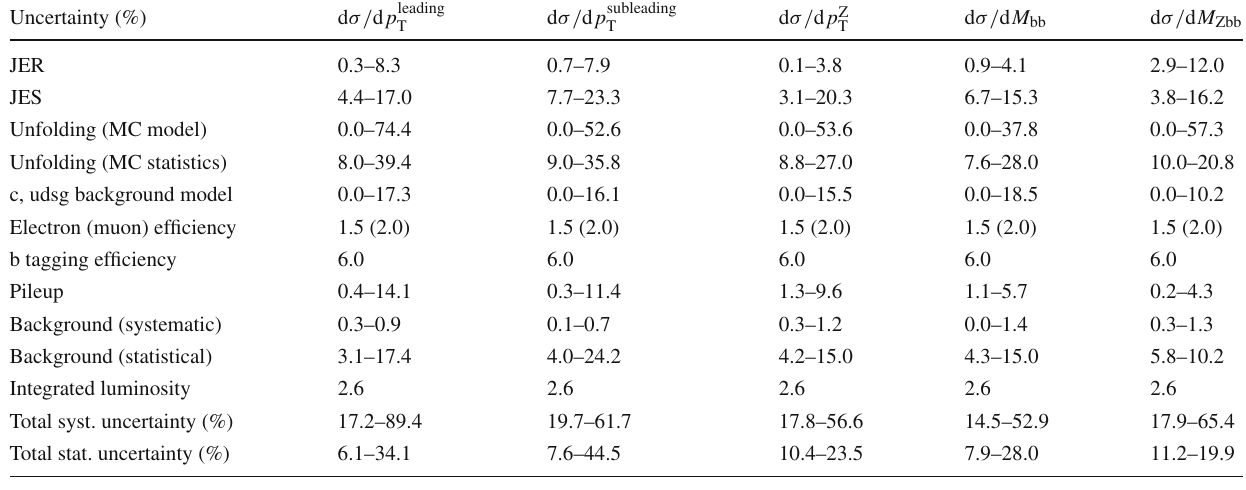
percent) in the differential cross sections as a function of Δ R and Δφ between the two b-tagged jets, Δ R between the Z boson and the closer b-tagged jet, and the asymmetry A Zbb , for